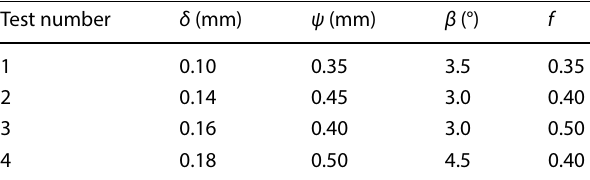
Where β = The centerline of the roller and liner axis Angle; f = Axial feed roller